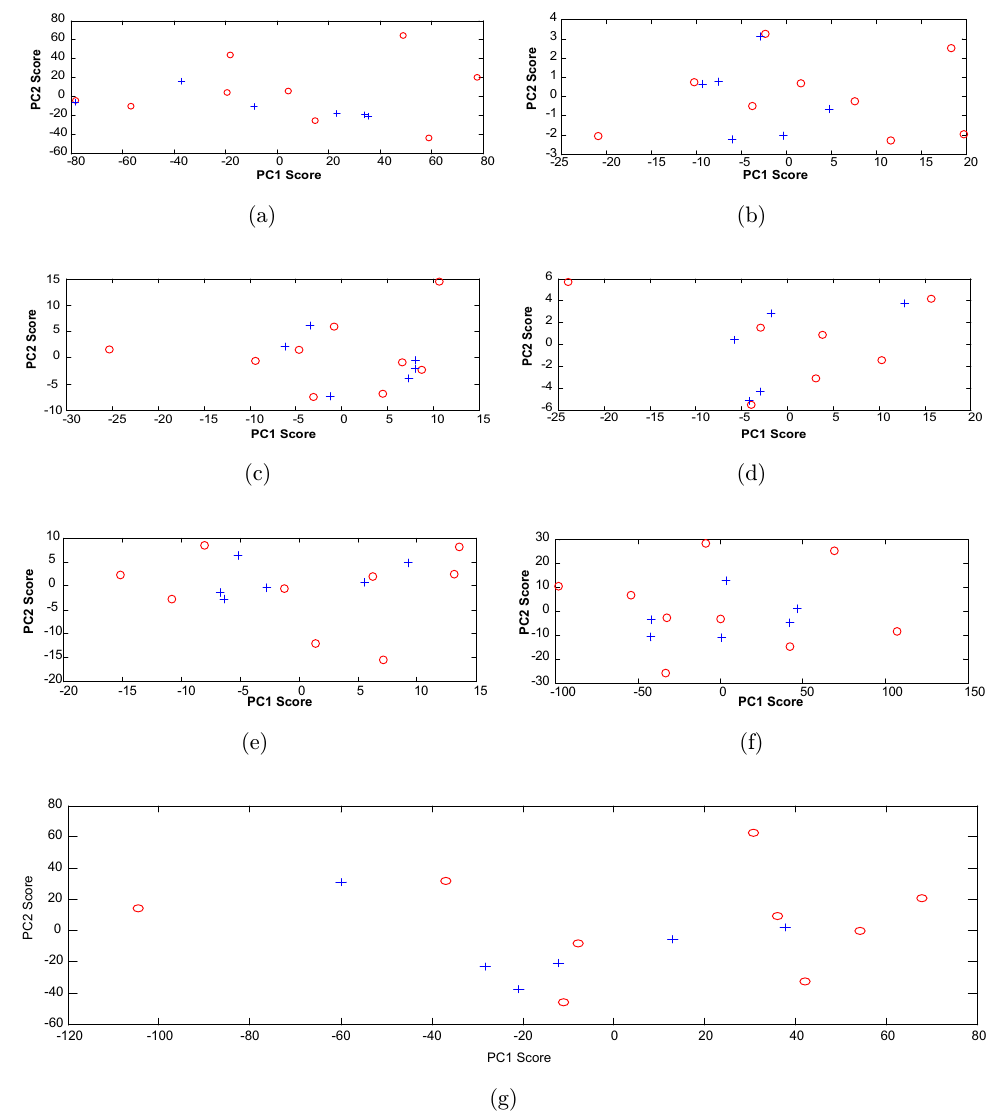
Fig. 4. The scores of all the seven samples with PCA. (a) Baitiao (Gansu); (b) Dongdang (Northeast); (c) Ludang (Shanxi); (d) Chuandang (Sichuan); (e) Wendang (Gansu); (f) Sulfur Baitiao (Gansu); and (g) Radix Stellariae (Ningxia).